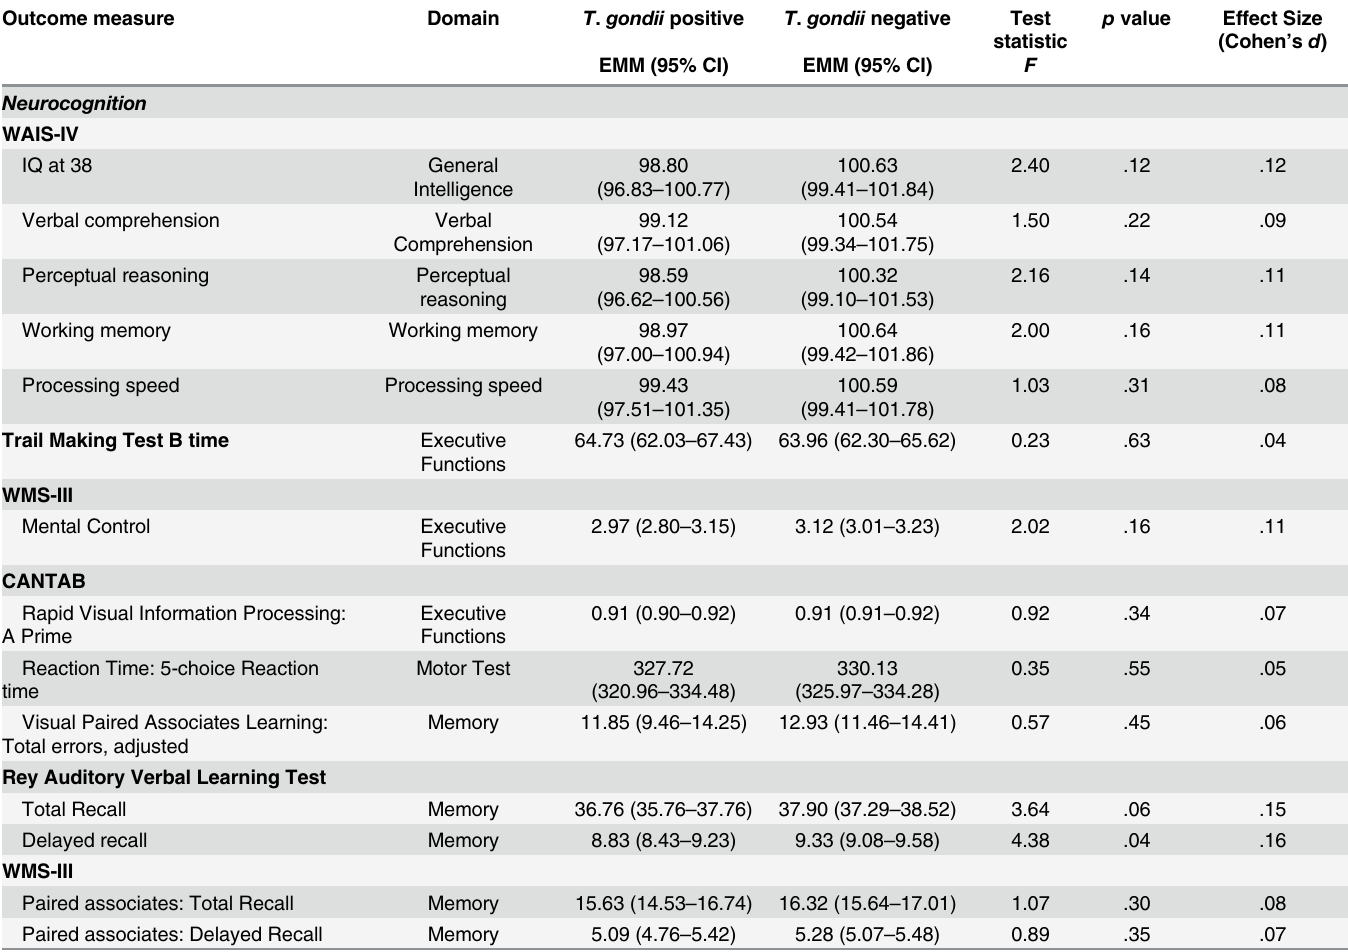
Table 3. The association between T . gondii infection status and neurocognitive